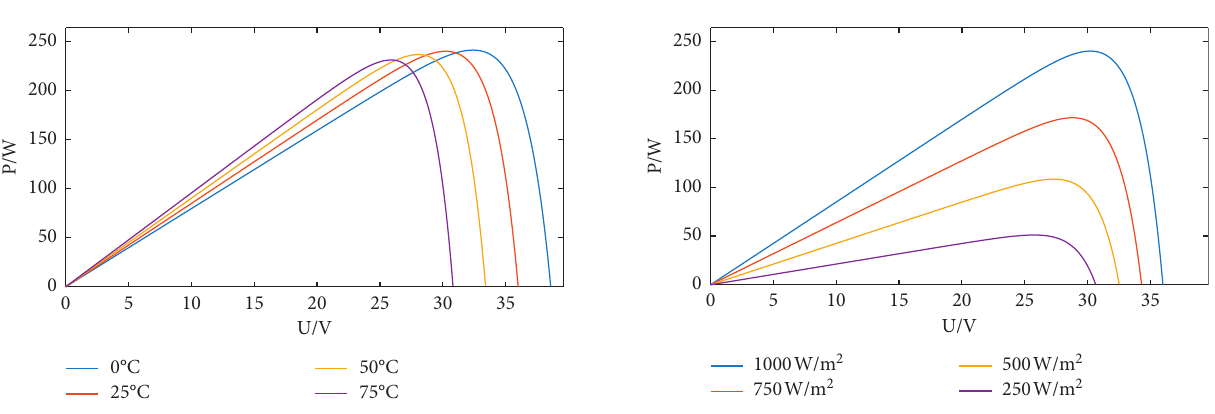
Figure 2: P-U output curve of the photovoltaic cell when tem- perature